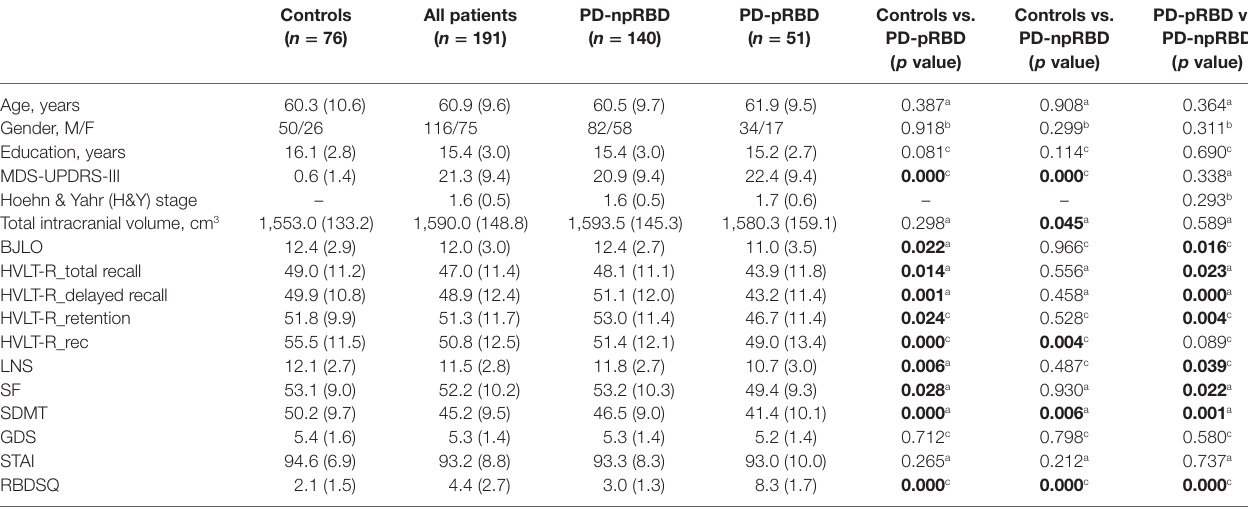
Presented by mean (SD). Bold for p < 0.05. a Calculated using independent sample T test.